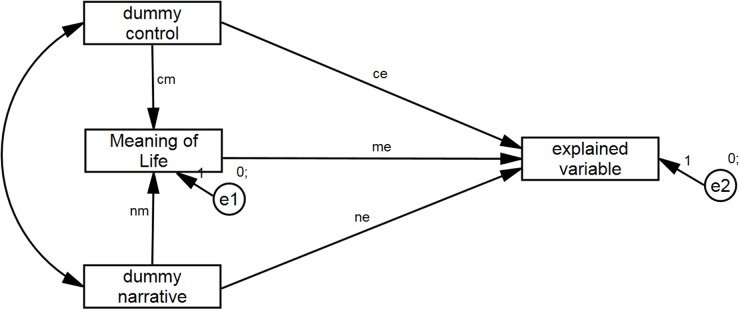
General mediation model.